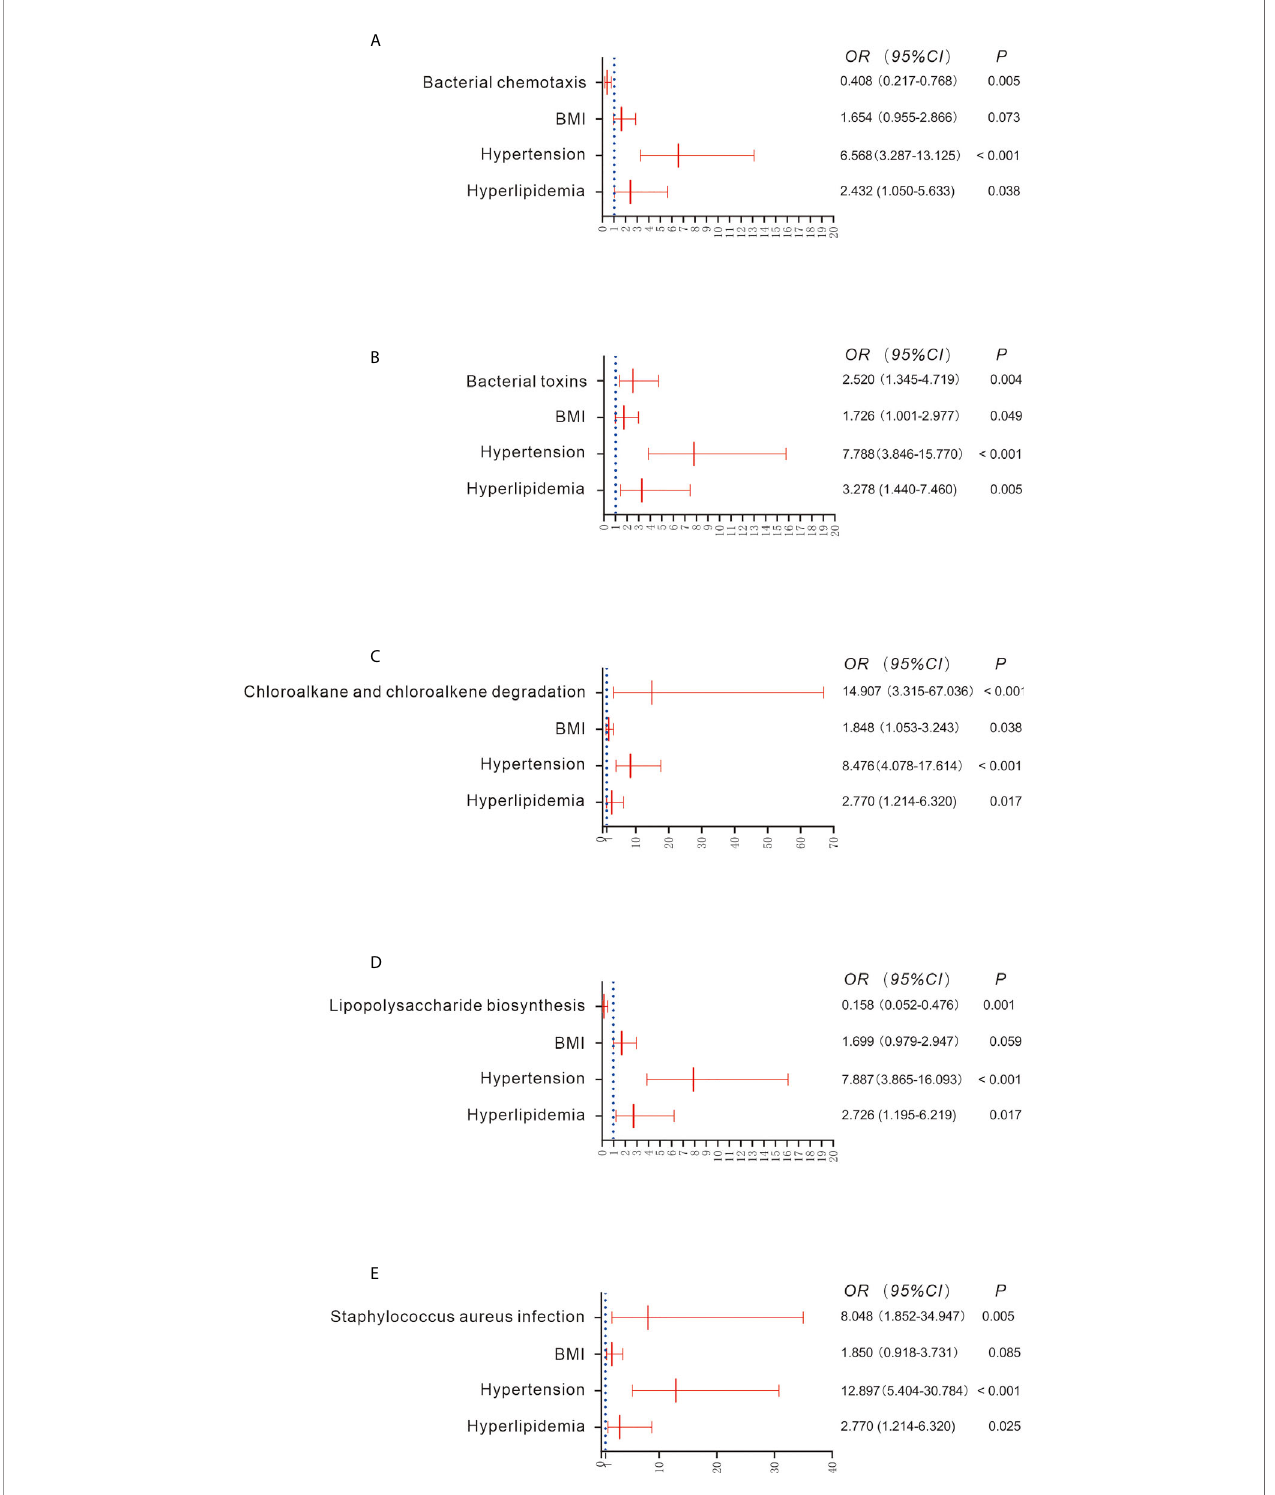
FIGURE 3 | Comparison of functional pathways between the CKD and HC groups (A – E) . Gene functions were predicted based on 16S rRNA gene-based microbial compositions using the PICRUSt algorithm and the Kyoto Encyclopedia of Genes and Genomes database. Binary regression analysis was used to adjust for confounders of BMI, hypertension and hyperlipidemia. The estimated ORs and their CIs are displayed as forest graphs. The blue dotted line represents the OR value =